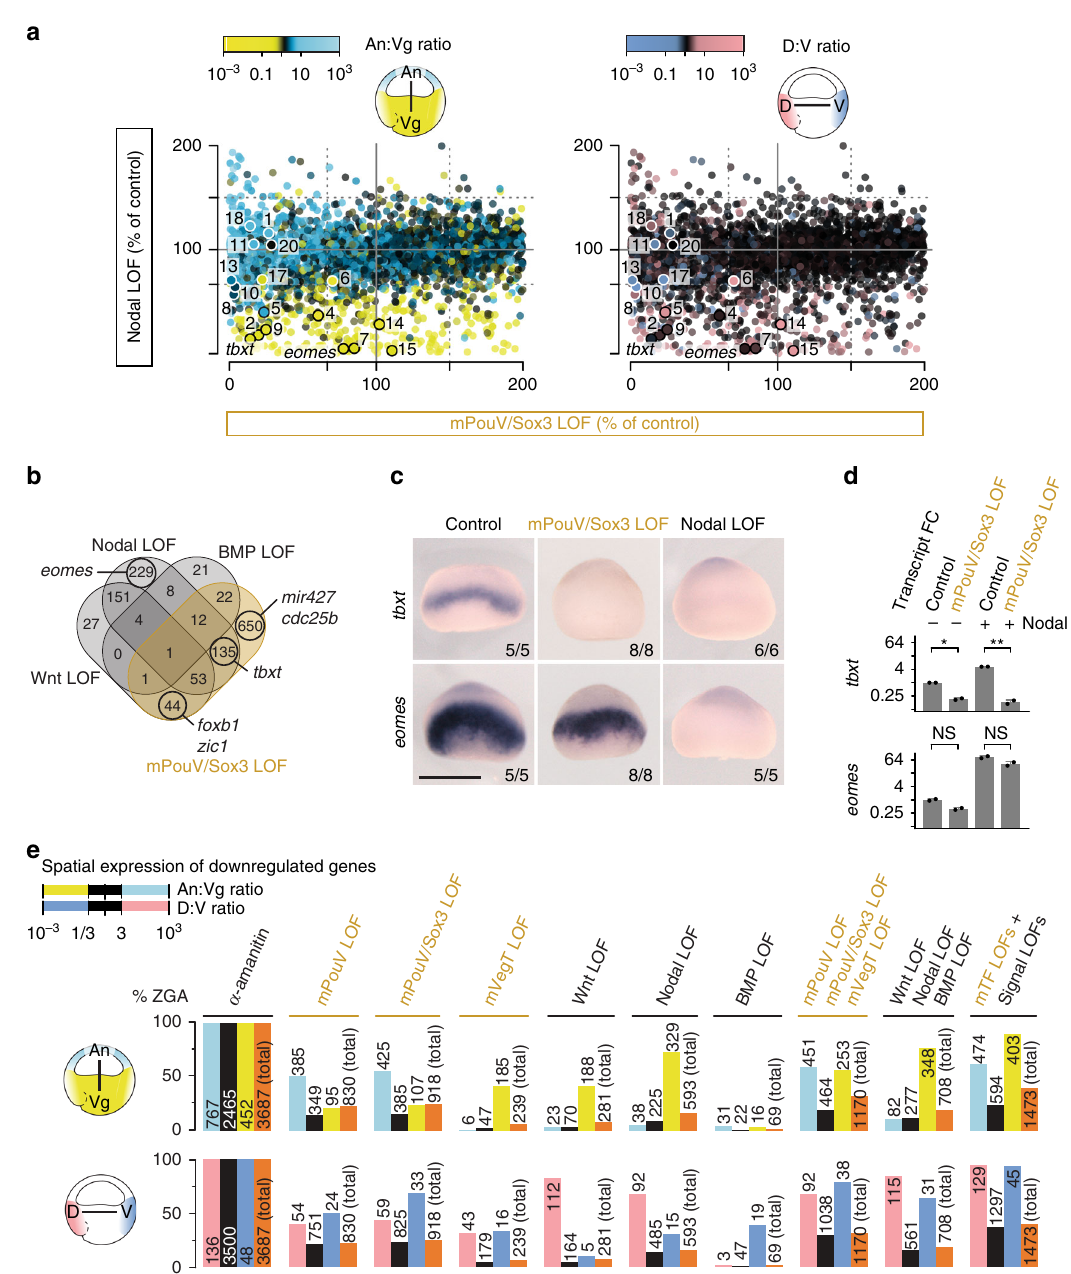
Fig. 7 Signal-induced regionalisation of ZGA depends on maternal TFs. a Transcriptional comparison of zygotic genes between the LOFs of maternal PouV/ Sox3 and Nodal signalling. Dots are coloured according to the normal ratio of transcript levels (regional expression 79 ) across the animal-vegetal (An:Vg) or dorso-ventral (D:V) axis. Numbered dots refer to genes listed in Fig. 6e. b Venn diagram of genes downregulated by the mPouV/Sox3 LOF (orange) or the LOF of single signal transduction pathways (black). c Early gastrula-staged WMISH for tbxt and eomes under indicated LOFs. Scale bar, 0.5 mm. d Quanti fi cation of tbxt and eomes transcript levels in control and mPouV/Sox3 LOF animal caps with or without stimulated Nodal signalling. Error bars, mean + s.d. ( n = 2 biologically independent samples). Two-tailed Student ’ s t -test: * p = 0.014; ** p = 0.005; and NS, not signi fi cant ( p ≥ 0.02). e Bar graphs show the percentage (and number) of downregulated zygotic genes (% ZGA under indicated LOFs) grouped by the normal ratio of transcript levels (regional expression 79 ) across the animal-vegetal (An:Vg) and dorso-ventral (D:V)